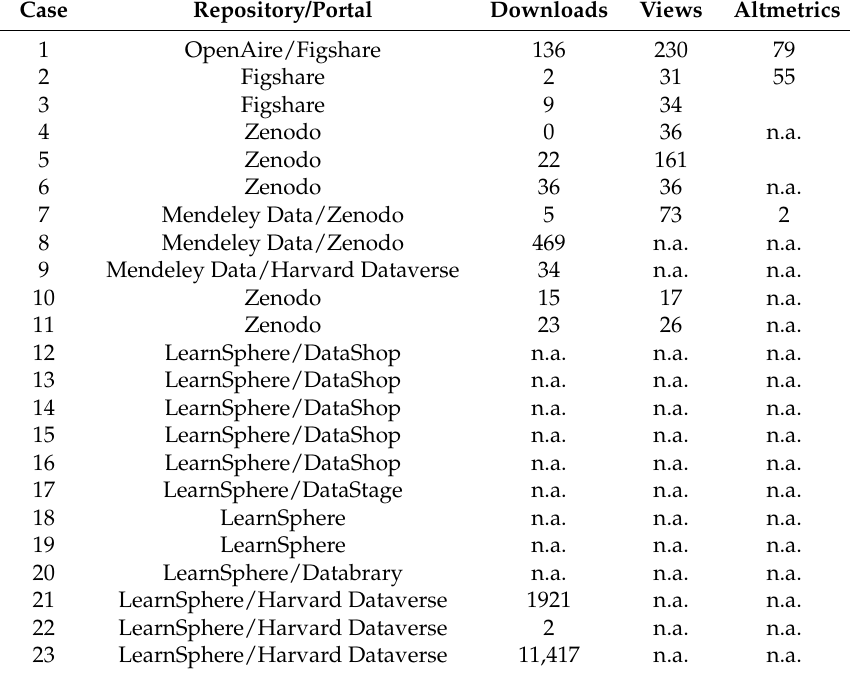
Table 3. Metrics of social